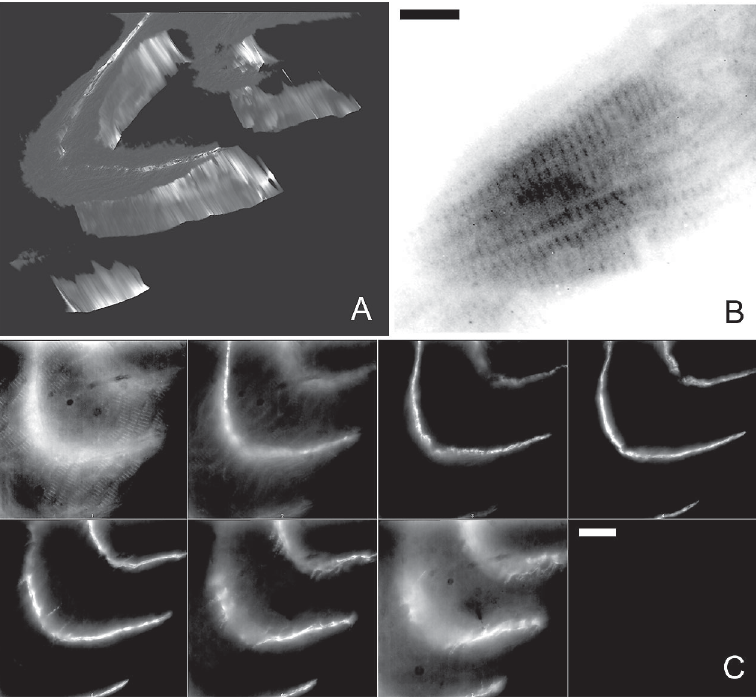
Figure 2. Somite structure. The connective tissue “box” can be seen in the three-dimen- sional reconstruction (A), generated from the seven separate focal planes of the immuno- fluorescence stain of somite 20 of zebrafish embryos with anti-vinculin antibodies (C). Between the septa, vimentin is distributed in striations in the myocytes, shown in this inverted contrast immunofluorescence stain of somite 10 of zebrafish embryos (B). Scale bars: B = 10 µm; C = 20